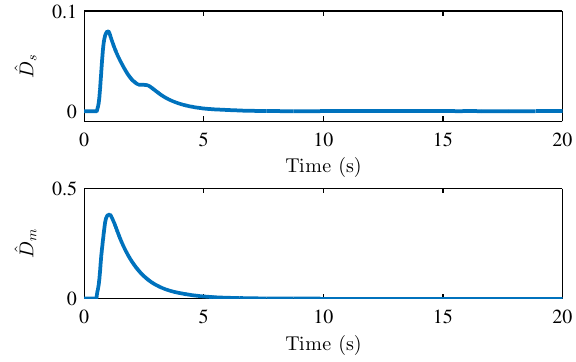
Figure 7. Adaptive parameters ˆ D s and ˆ D m .